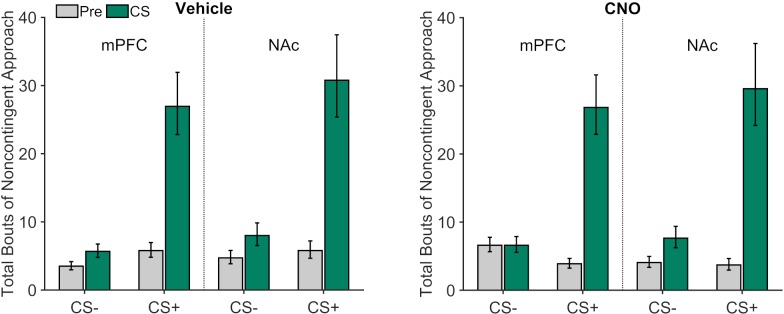
Noncontingent (press-independent) food-cup approaches during PIT testing in rats expressing the inhibitory DREADD hM4Di following microinjection of CNO or vehicle into the mPFC or NAc in Experiment 3A.Data from pre-CS (gray) and CS (green) periods are plotted separately. Error bars represent ±1 standard error of the estimated marginal means from the corresponding fitted generalized linear mixed-effects model. Noncontingent approach behavior was selectively elicited by the CS+ but not the CS- (CS Period * CS Type interaction, t(240) = 12.98, p<0.001). CNO administration led to a very modest but reliable enhancement in the tendency for the CS+ to increase this behavior over baseline levels (Drug * CS Type * CS Period interaction, t(240) = 2.98, p=0.0032), which did not depend on injection site (Drug * Site * CS Type * CS Period interaction, t(240) = −1.45, p=0.147). CNO did not have any general (cue-independent) effects on this response (Drug effect, t(240) = −0.41, p=0.680; Site effect, t(240) = 0.75, p=0.456; Drug * Site interaction, t(240) = −0.96, p=0.338).